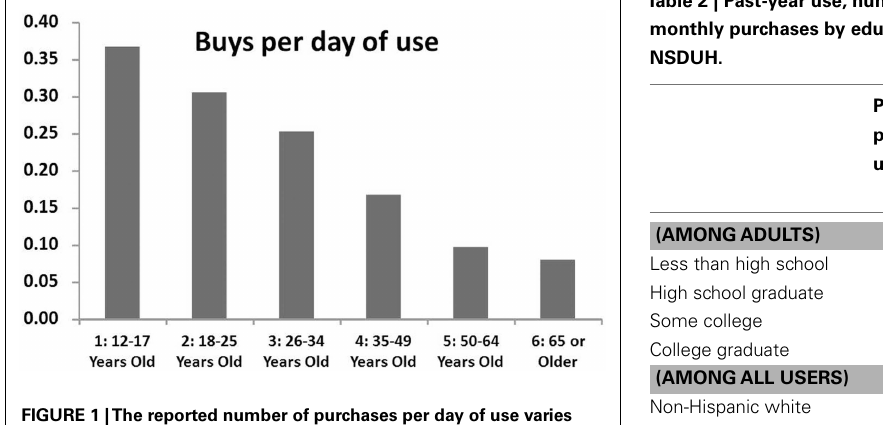
Table 2 | Past-year use, number of drug-related arrests, and number of monthly purchases by education level and racial-ethnic group,